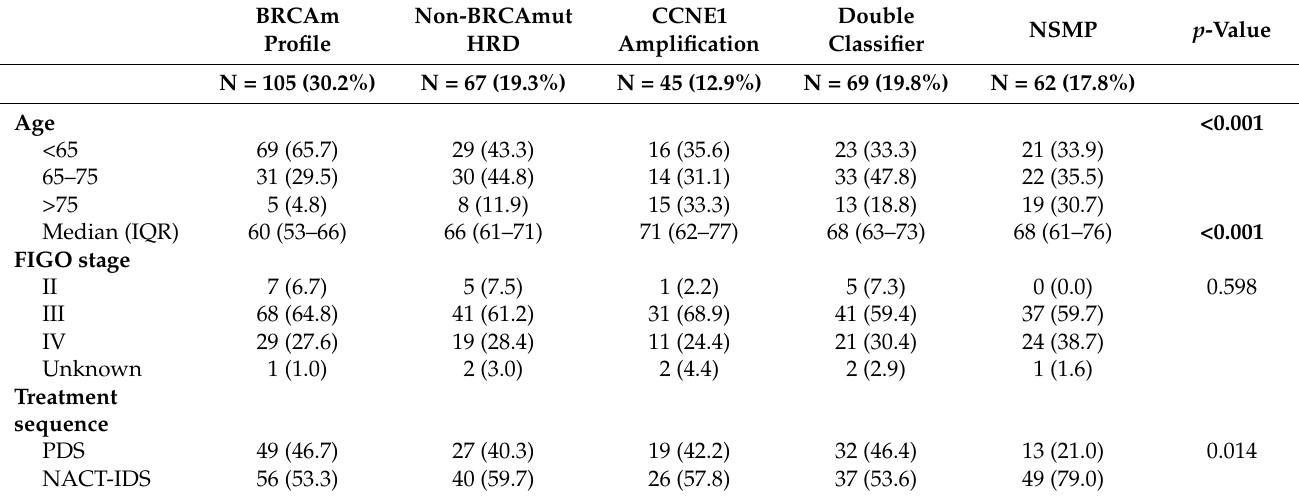
Table 1. Patient